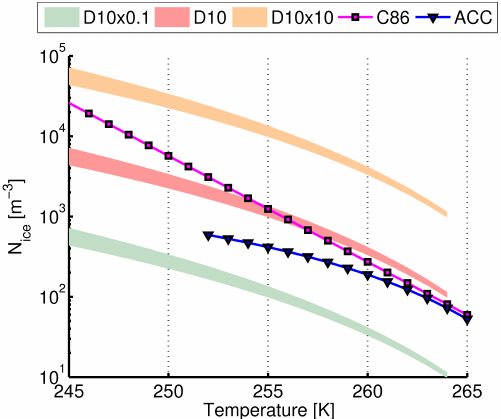
Figure 1. Evaluation of the five parameterisations used (C86, D10, ACC, D10 × 0.1, and D10 × 10) in the three cases considered with respect to temperature. The C86 parameterisation and ACC are valid for all cases, whereas the different aerosol particle loadings, and thus, variability, are accounted for with the D10 parameterisa-